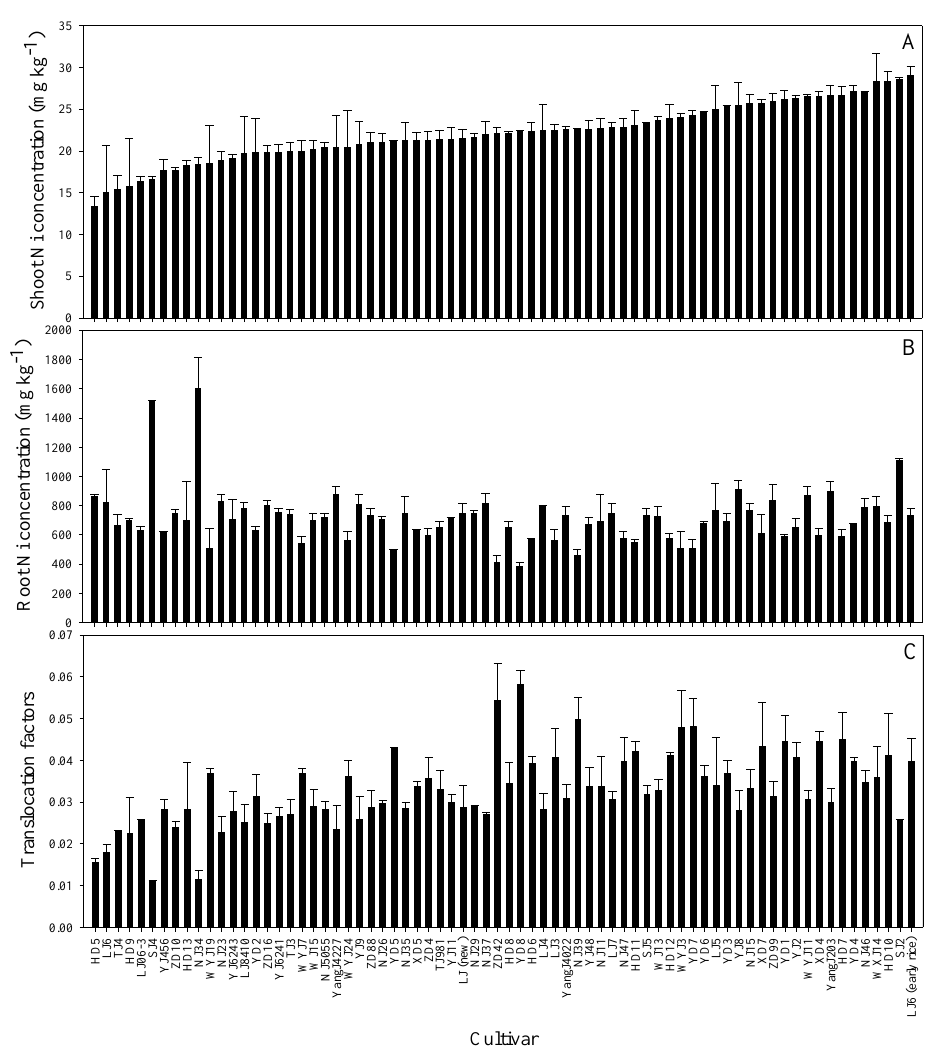
Figure 1. Nickel (Ni) concentrations in shoots ( A ), roots ( B ), and translocation factors ( C ) of 72 different rice seedlings. Data are means ± standard deviation (n = 3). Shoot Ni concentrations varied from 13.3 mg·kg −1 in HD5 to 29.1 mg·kg −1 in the early rice LJ6 (geometric mean: 22.1 mg·kg −1 , median: 22.1 mg·kg −1 ; Figure 1A). Root Ni concentrations varied